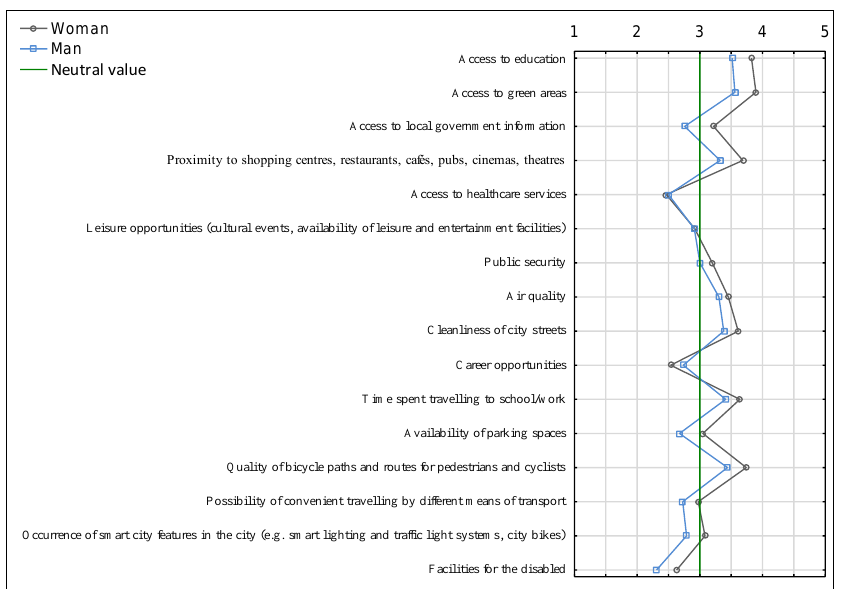
Figure 12. Semantic differential of the level of satisfaction with individual aspects of the functioning of the city of Suwałki. Source: own study based on questionnaire surveys.